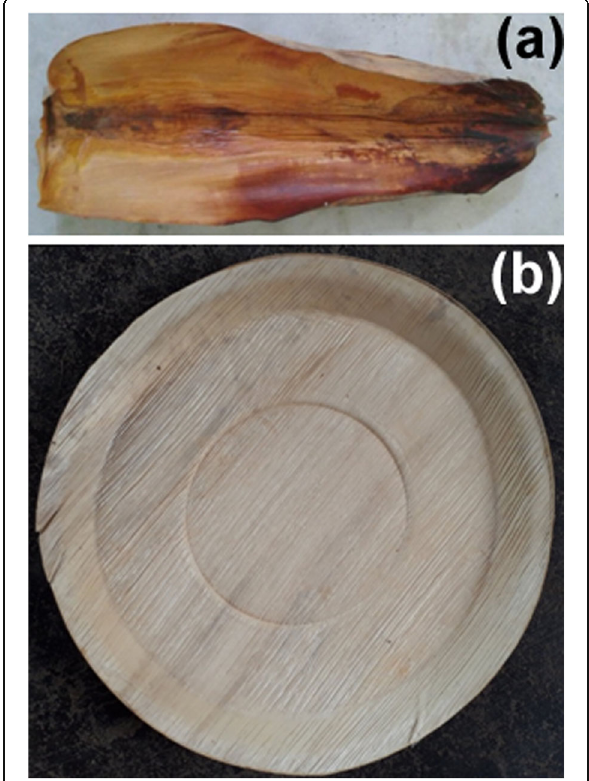
Fig. 2 a The leaf sheath of vakka , A. catechu and ( b ) the machine compressed dining plate made from the leaf sheath of